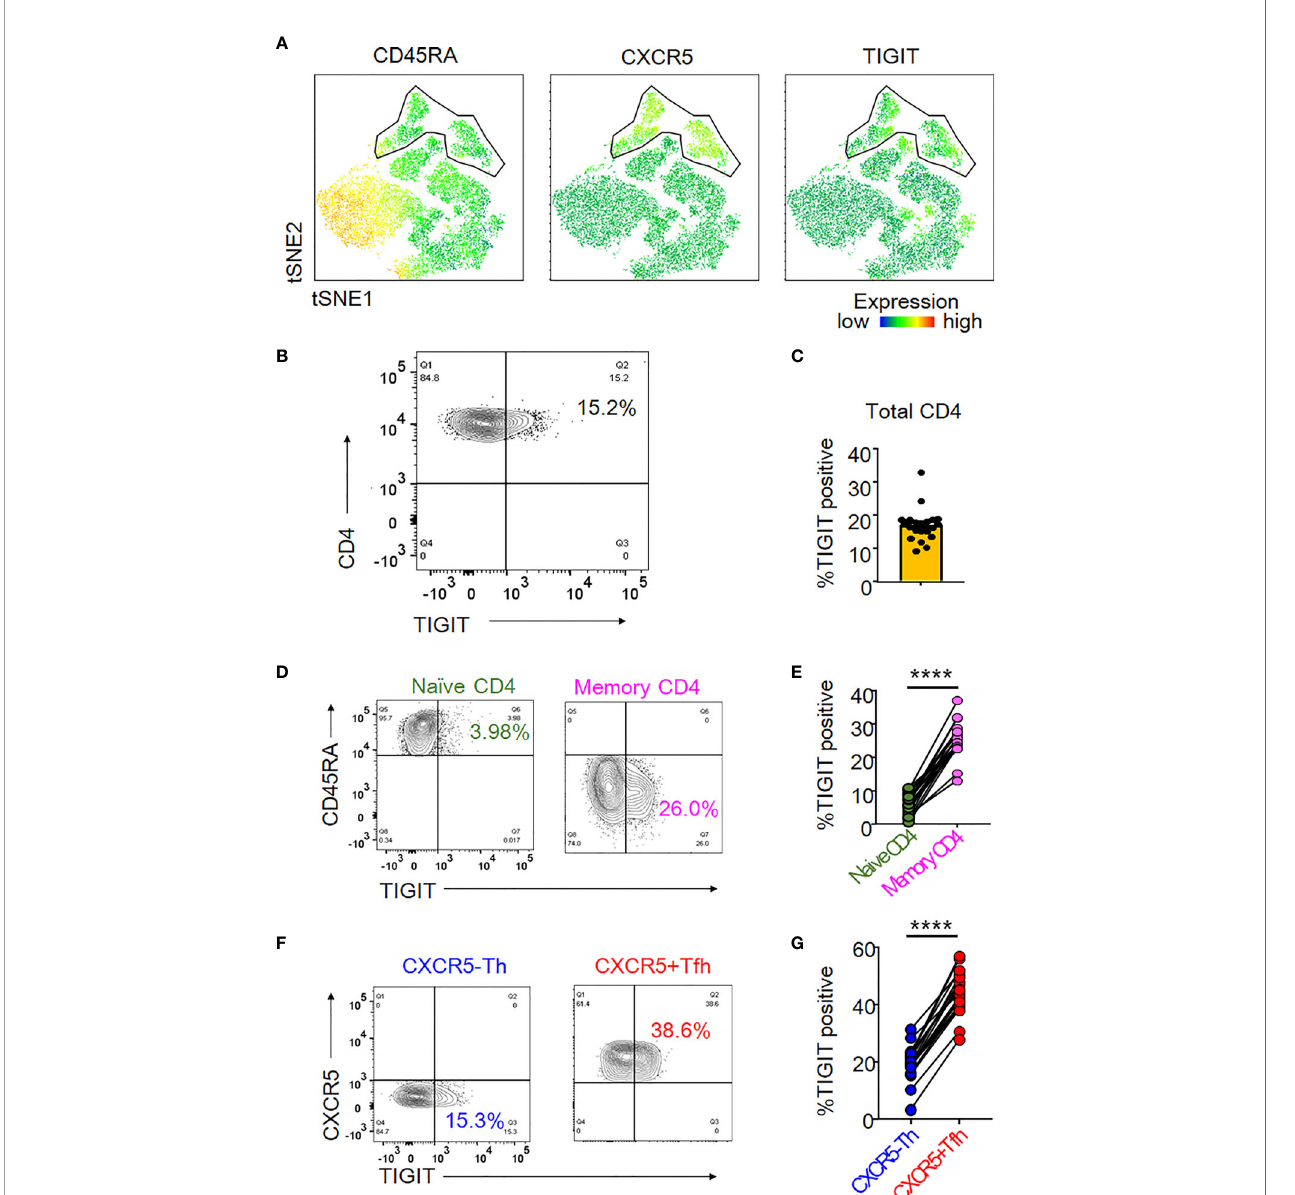
FIGURE 1 | TIGIT expression in peripheral Tfh cells. (A) Single cells of CD3 + CD4 + T cell types were plotted by t-Distributed Stochastic Neighbor Embedding (tSNE). Heat maps show expression levels of labeled markers (CD45RA, CXCR5, and TIGIT). Enclosure shows CD45RA-CXCR5+T follicular helper (Tfh) cell population. (B, C) The proportion of TIGIT + cells was analyzed in total CD4 + T cells from healthy individuals by fl ow cytometry. (A) , representative image. (B) , multiple analyses of the proportion of TIGIT + cells in total CD4 + T cells (n=21). (D, E) Proportion of TIGIT + cells was analyzed in naïve (CD45RA + ) and memory (CD45RA - ) CD4 + T cells. (D) , representative image. (E) , multiple comparison of the proportion of TIGIT + cells in naïve and memory CD4 + T cells (n=21). (F, G) Proportion of TIGIT + cells was examined in CXCR5 - CD45RA - CD4 + T helper cells (CXCR5 - Th) and CXCR5 + CD45RA - CD4 + Tfh (CXCR5 + Tfh) cells. (F) , representative image. (G) , multiple comparisons of the proportion of TIGIT + or TIGIT - cells in CXCR5 - Th and CXCR5 + Tfh cells (n=21). (D, G) paired t-test.